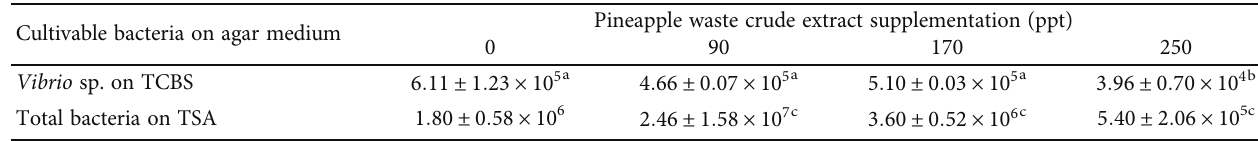
Table 6: Colony forming unit (CFU/g) of cultivable bacteria in hepatopancreas content of Paci fi c white shrimp fed with pineapple waste crude extract supplementation diet at di ff erent levels for 80